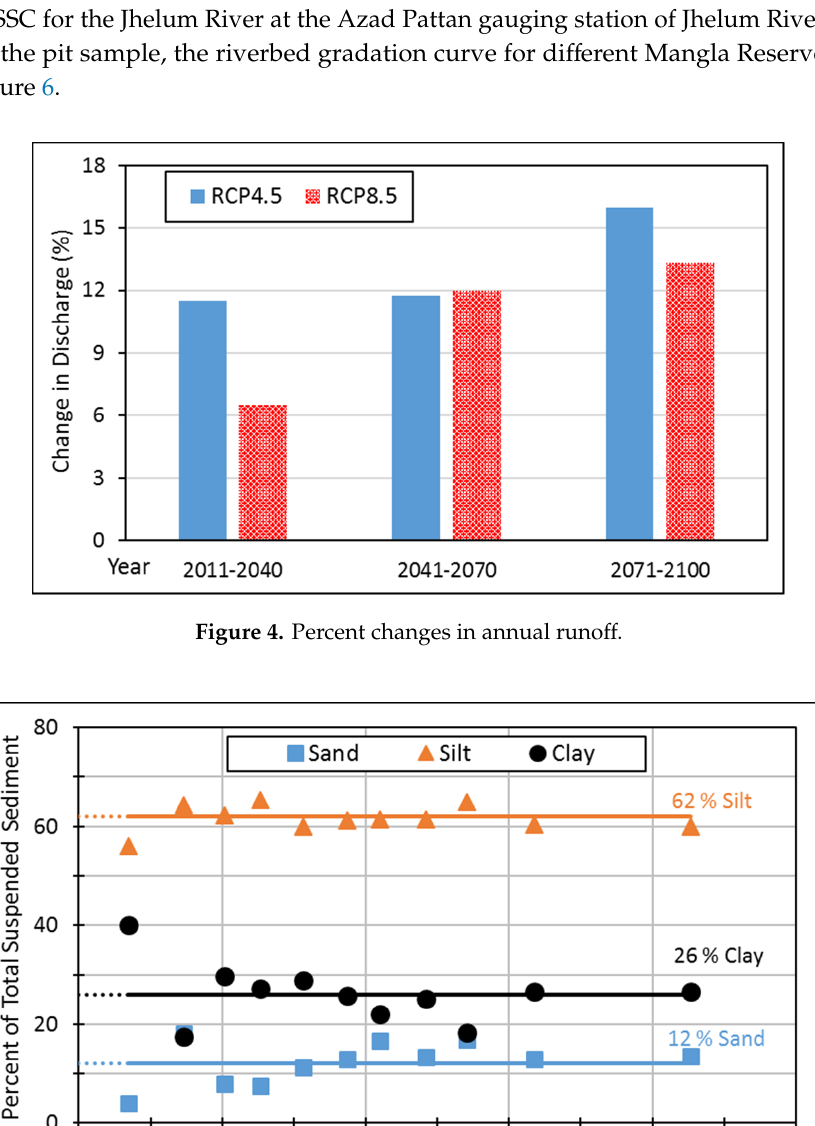
Figure 4. Percent changes in annual runoff.